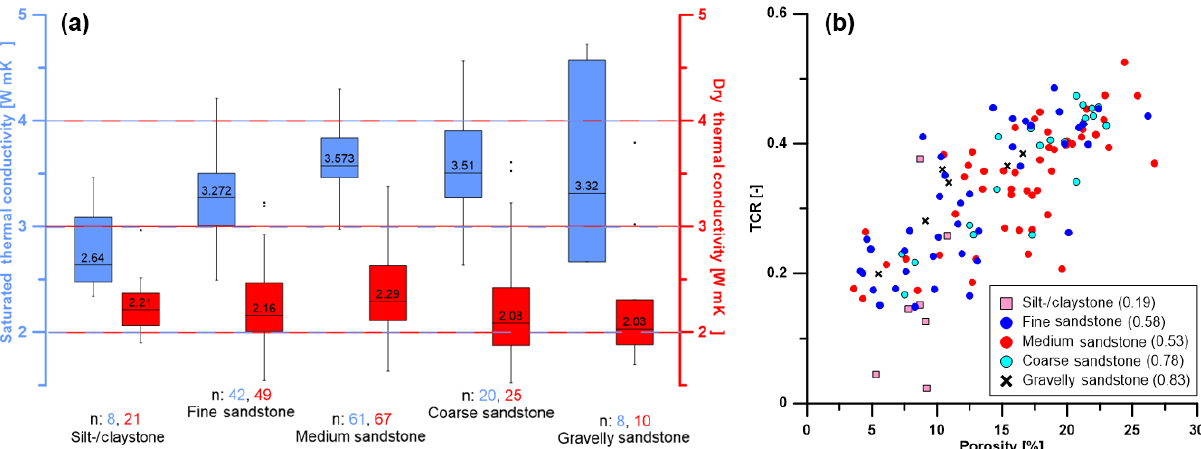
Figure 4. (a) Thermal conductivity data measured on fully water saturated and oven-dry core samples of eight boreholes. The values inside the boxes show the median. n : Number of samples. (b) Thermal conductivity ratio (TCR; Eq. 3) against porosity. The values given in the legend are the coefficients of determination for a linear regression.